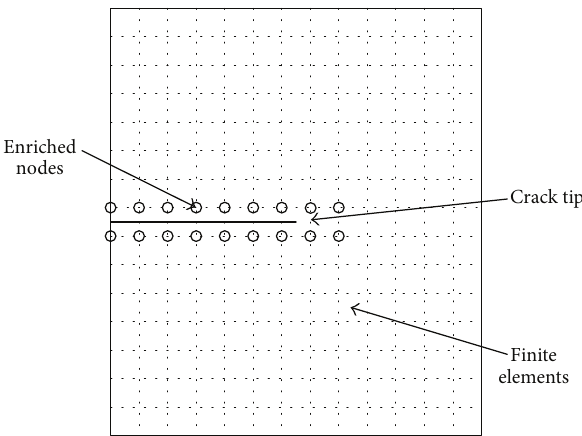
Figure 6: One enriching strategy near the crack. shows programming for generation of representative volume element square (RVE).